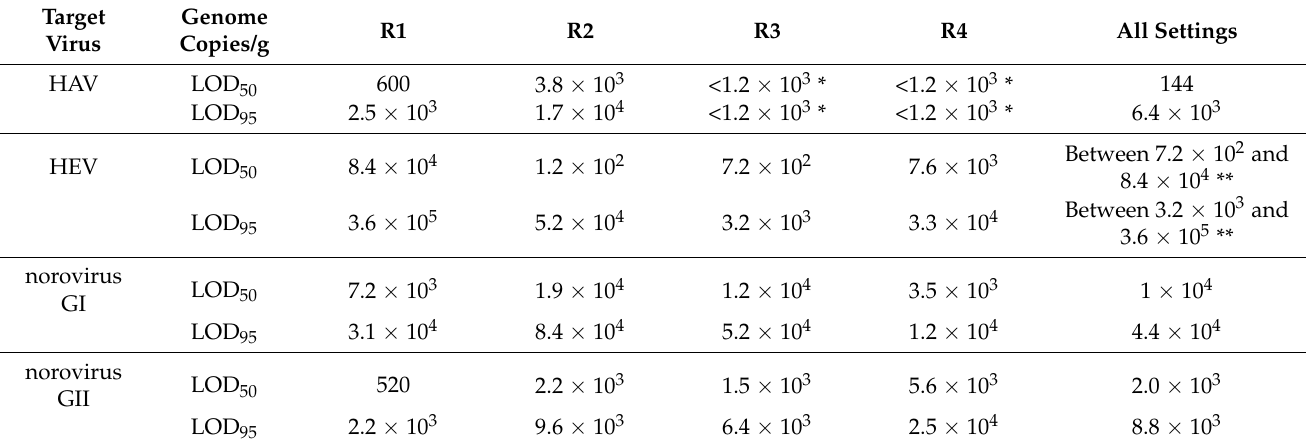
Table 6. Limit of detection (LOD 50 and LOD 95 ) for HAV, HEV, and norovirus according to the